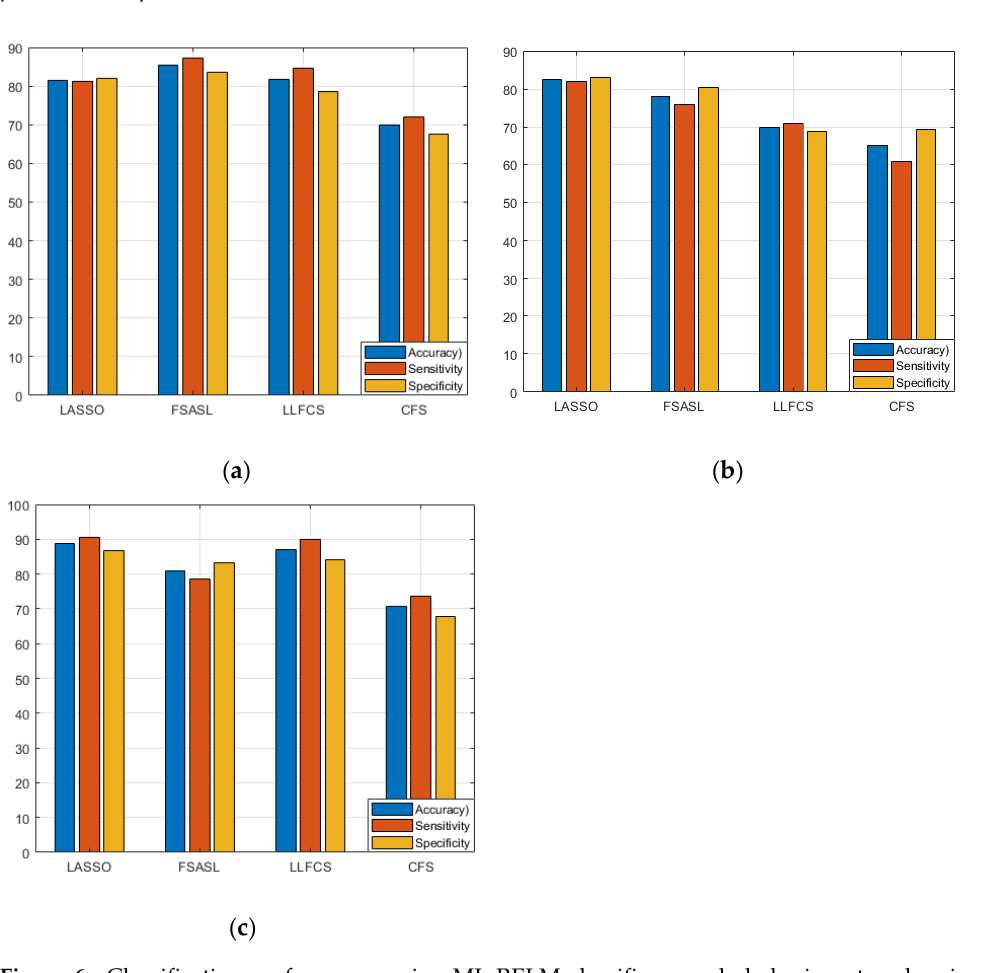
ferent feature selection methods. ( a ) AD against HC; ( b ) HC against MCI; ( c ) MCI against AD.